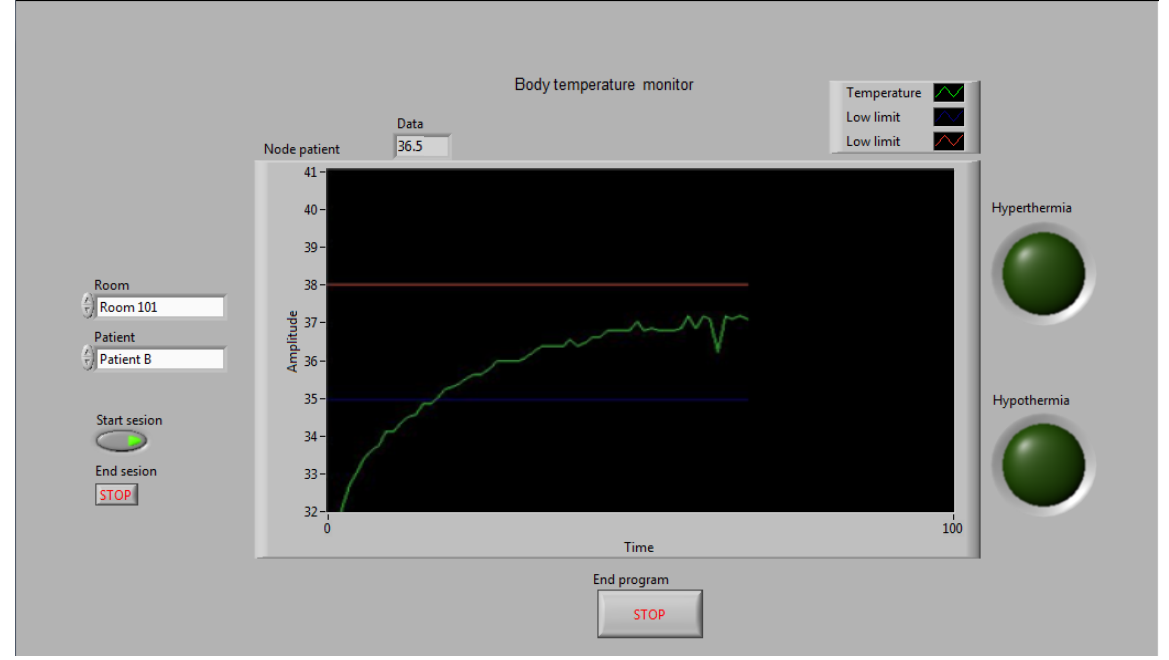
Figure 9. Monitor screen of the NSI showing the BT behavior of the last patient node measured in ◦ C.